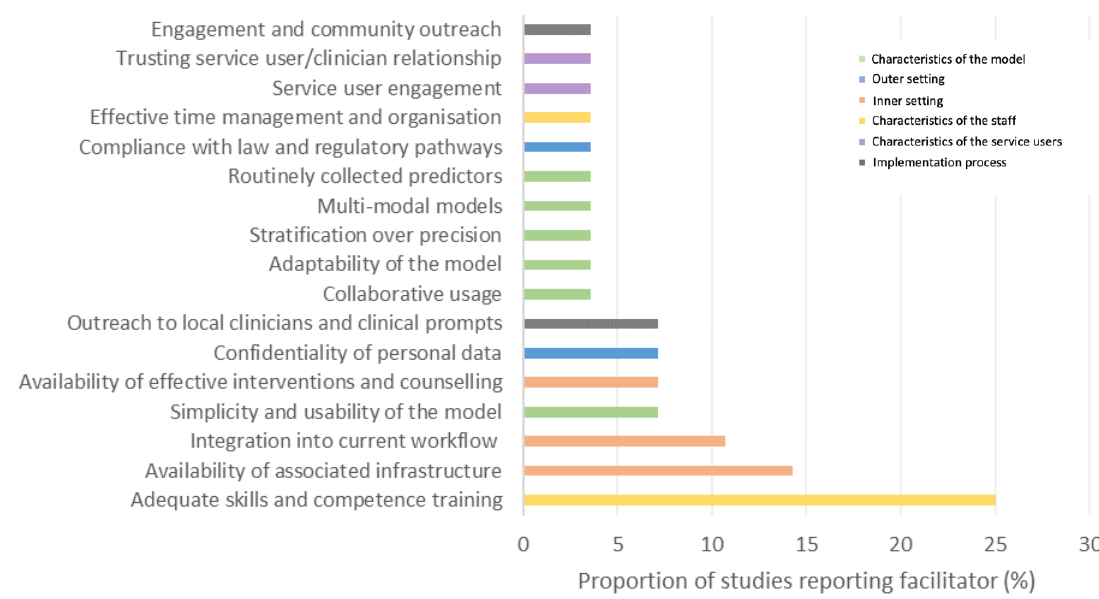
Figure 6. Proportion (%) of the included studies reporting each barrier.